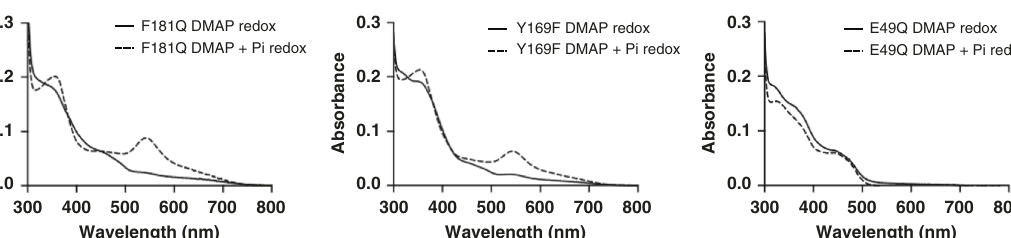
2 when phosphate